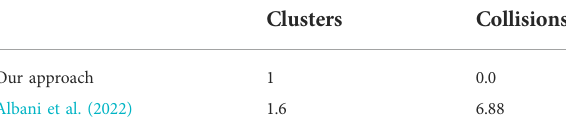
TABLE 2 Reportedaveragenumber of detectedclusters and collisions over 10 runs for “ our approach ” and the work of Albani et al.